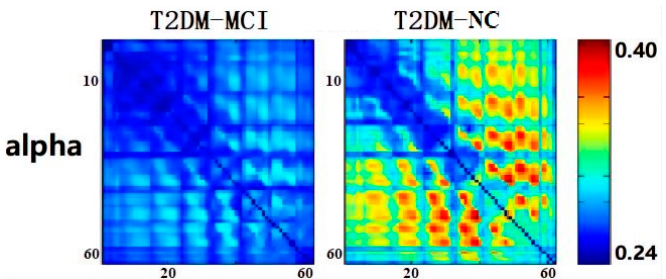
Figure 3. The alpha band matrix of phase lag index in the T2DM-MCI group ( left ) and the T2DM-NC group ( right ). Here, 1 to 62 electrodes are shown from left to right, top to bottom. The color bars indicates the phase lag index values.